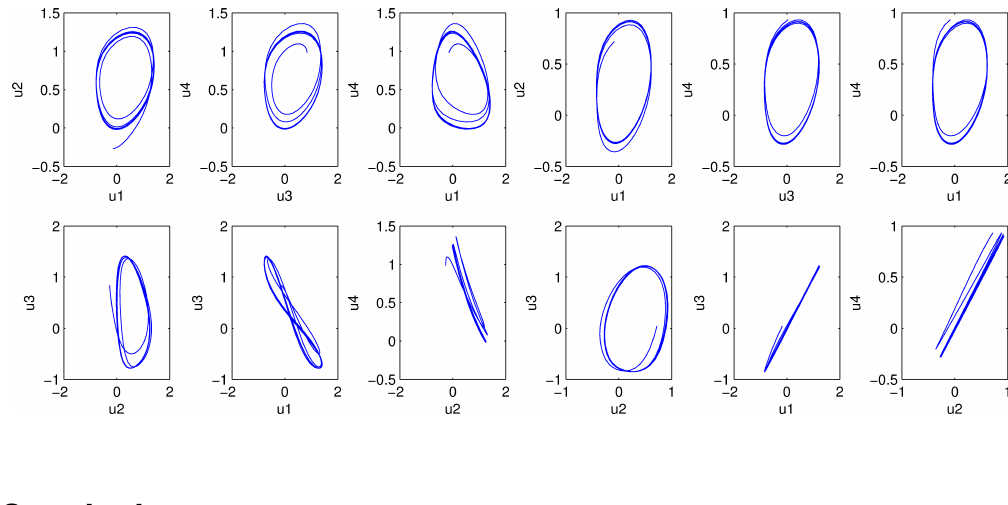
Fig. 3. Dynamic patterns in RD-BCNN with memristor